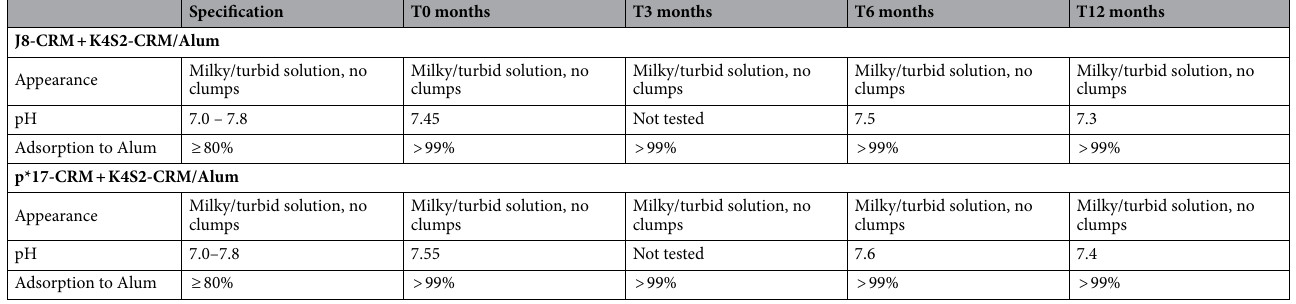
Table 4. Stability result